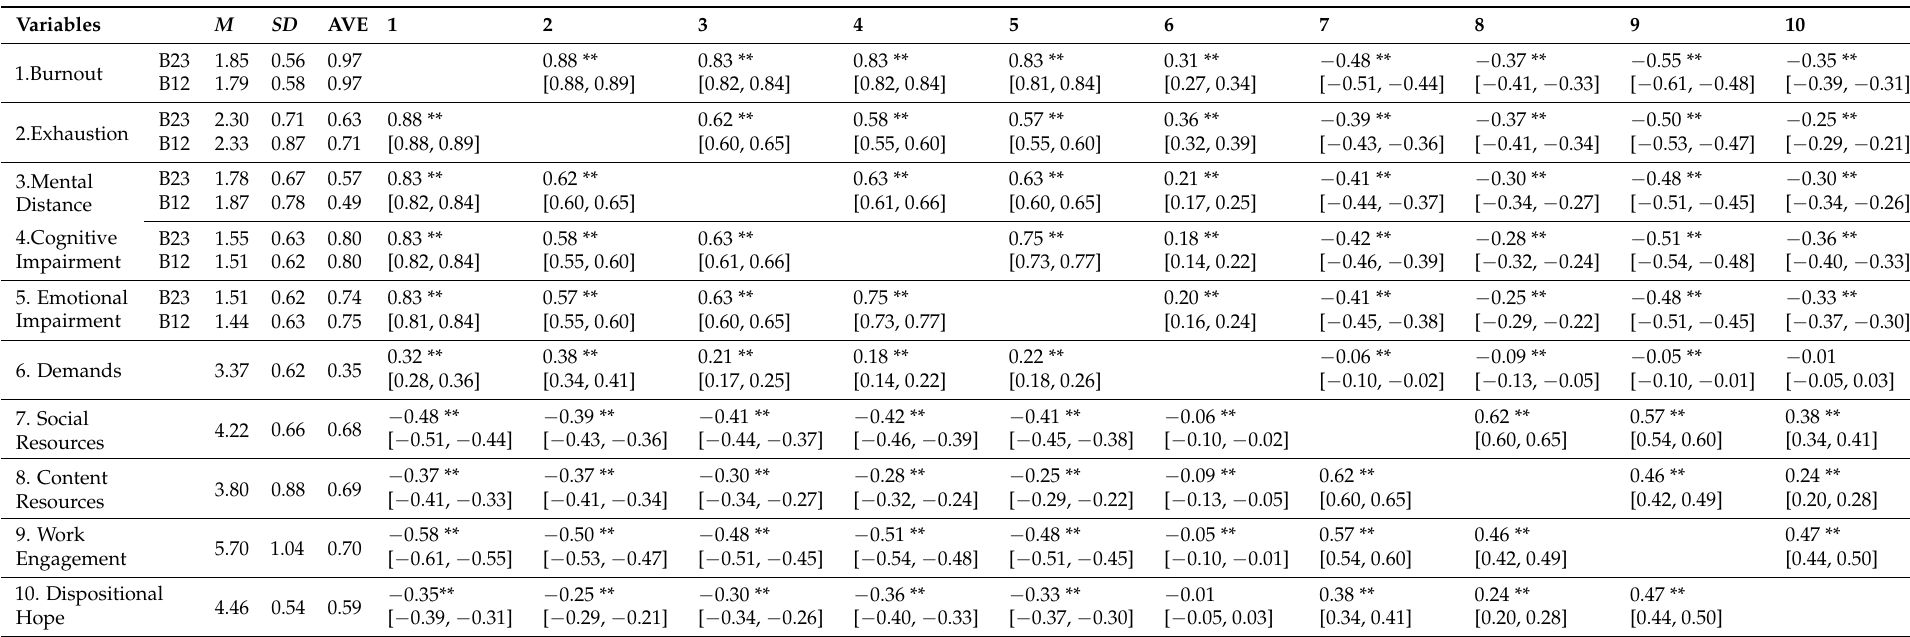
Table 4. Relationships between burnout, work engagement, dispositional hope and the job demands-resources